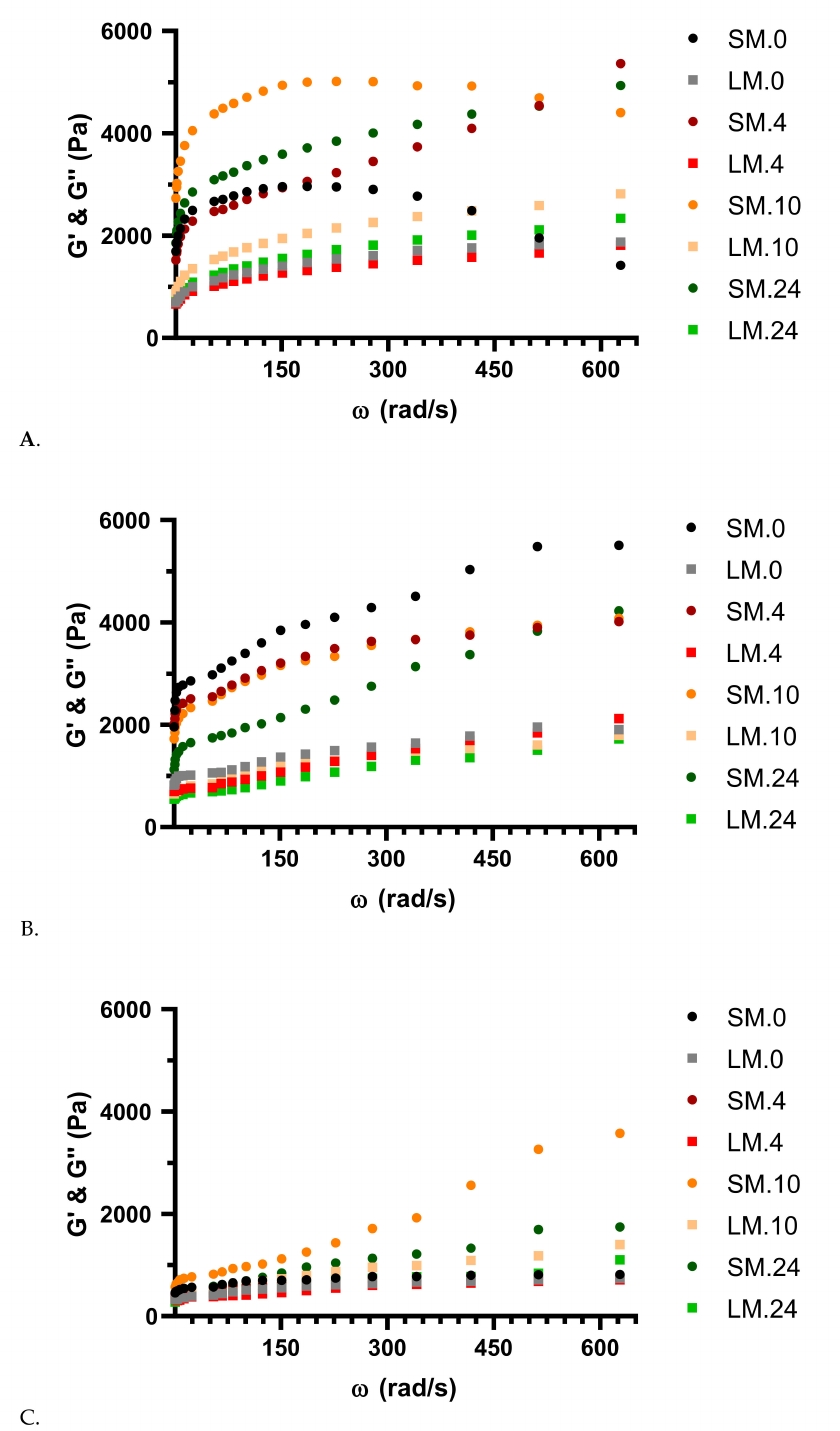
Figure 3. Storage (SM—G (cid:48) , filled dots • ) and loss modulus (LM—G (cid:48)(cid:48) , filled squares (cid:4) ) performed as a function of angular frequency ( ω ) in doughs at di ff erent strengths for ( A ) batch A (90% WF + 10% SF addition); ( B ) batch B (95% WF + 5% SF addition); ( C ) batch C (100% WF) fermented with the coculture of LP and LC through a 24 h